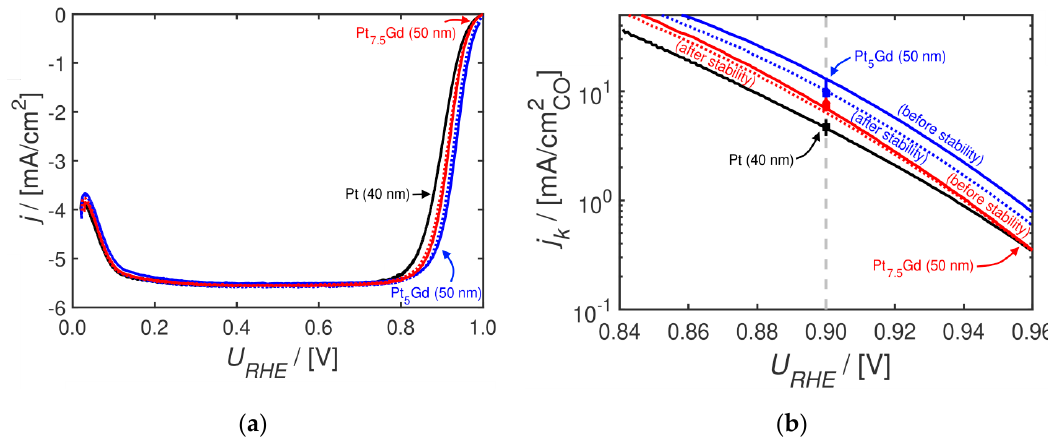
Figure 5. ORR activity plots of 40 nm Pt, 50 nm Pt 5 Gd (blue) and Pt 7.5 Gd (red) thin films in O 2 -saturated 0.1-M HClO 4 electrolyte at 50 mV/s and 1600 rpm at room temperature both before (full lines) and after stability (dashed lines) tests; ( a ) Current density of the anodic ORR sweep using electrodes geometric area; ( b ) Tafel plot using the CO-oxidation area for charge density normalization, also shown is the average specific activities at 0.9 V vs. RHE (gray line) with error bars of minimum three measurements of each composition. The observed Tafel slopes were found to be very similar for all ∼ 63.1 mV ∼ 59.6 mV ∼ 58.1 mV ∼ 55.5 mV systems β Pt , β Pt , β Pt , β Pt at 0.9 V vs. dec . dec . dec . dec . Poly Thin film 5 Gd Thin film 5 Gd Poly RHE, Table 2. Electrochemical data for the 40 nm Pt as-prepared and 50 nm Pt 5 Gd and Pt 7.5 Gd thin films before and after AST . Specific activities were evaluated at 0.9 V vs. RHE and are shown both using the area derived from CO oxidation and hydrogen adsorption [37].